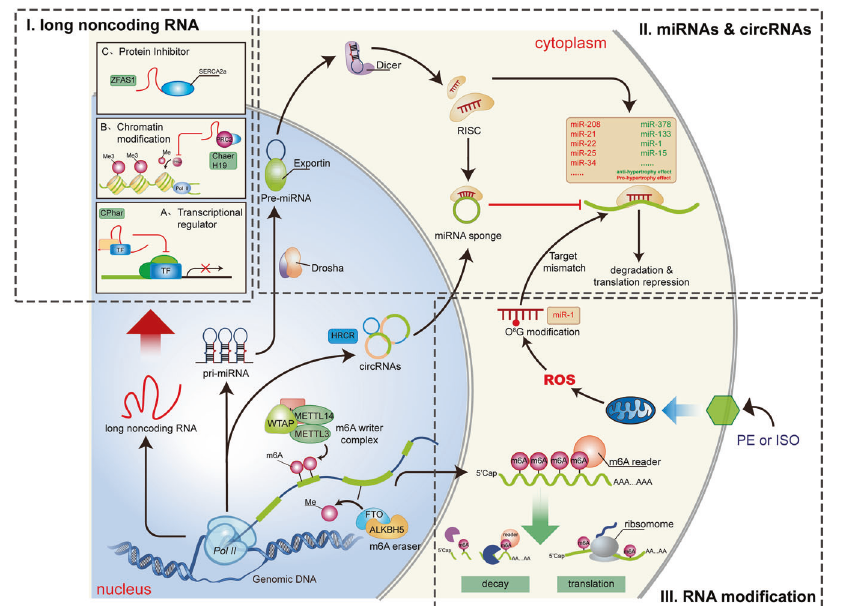
Fig. 2 RNA related mechanism of cardiac hypertrophy. Recent studies on RNA creates a novel regulatory network for cardiac hypertrophy. (I) Long non-coding RNAs (lncRNAs) are molecularly multi-functional. They can physically interact with and modulate function of cytoplasmic protein, chromatin remodeling factors, and transcription factors. (II) MicroRNAs (miRNAs) target mRNA and suppressed its expression. Circular RNAs (circRNAs) are also multifunctional, but cardiac hypertrophy related researches mainly focuses on their role as miRNA sponges. (III) RNA modi fi cation further adds to the complexity of the regulatory network. N6-methyladenosine (m6A) alters the function of mRNA. Modulating m6A “ writer ” or “ eraser ” can affect the development of cardiac remodeling. Oxidative stress creates 8-oxoguanine modi fi cation on miR-1, which leads to its target mismatch and triggers hypertrophic response. miRNA: microRNA; circRNA: circular RNA; ZFAS1: Zinc fi nger antisense 1; PRC2: polycomb repressor complex 2; Chaer: cardiac-hypertrophy-associated epigenetic regulator; SERCA2a: sarco/endoplasmic reticulum Ca2 + -ATPase 2a; CPhar: cardiac physiological hypertrophy-associated regulator; TF: transcription factor; RISC: RNA Induced Silencing Complex; HRCR: heart-related circRNA; ROS: reactive oxygen species; WTAP: Wilms ’ tumor 1-associating protein; METTL3: methyltransferase like